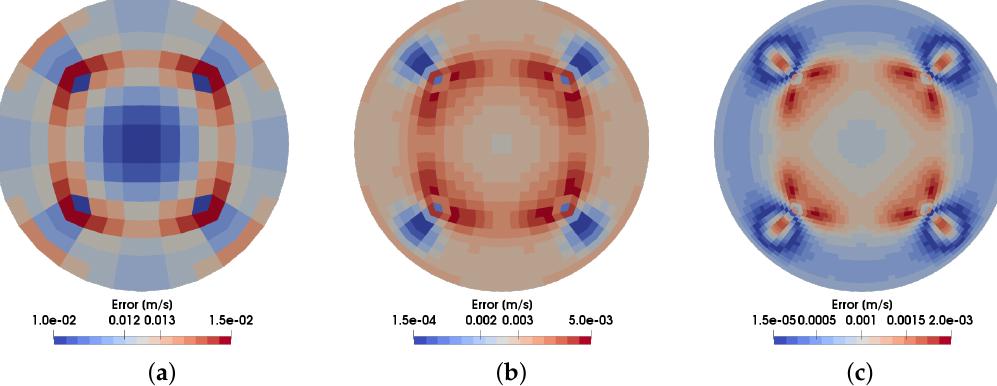
Figure 8. Absolute error of the axial velocity for a mesh with no twist. ( a ) coarse mesh (left); ( b ) intermediate mesh (center) and ( c ) fine mesh (right) are